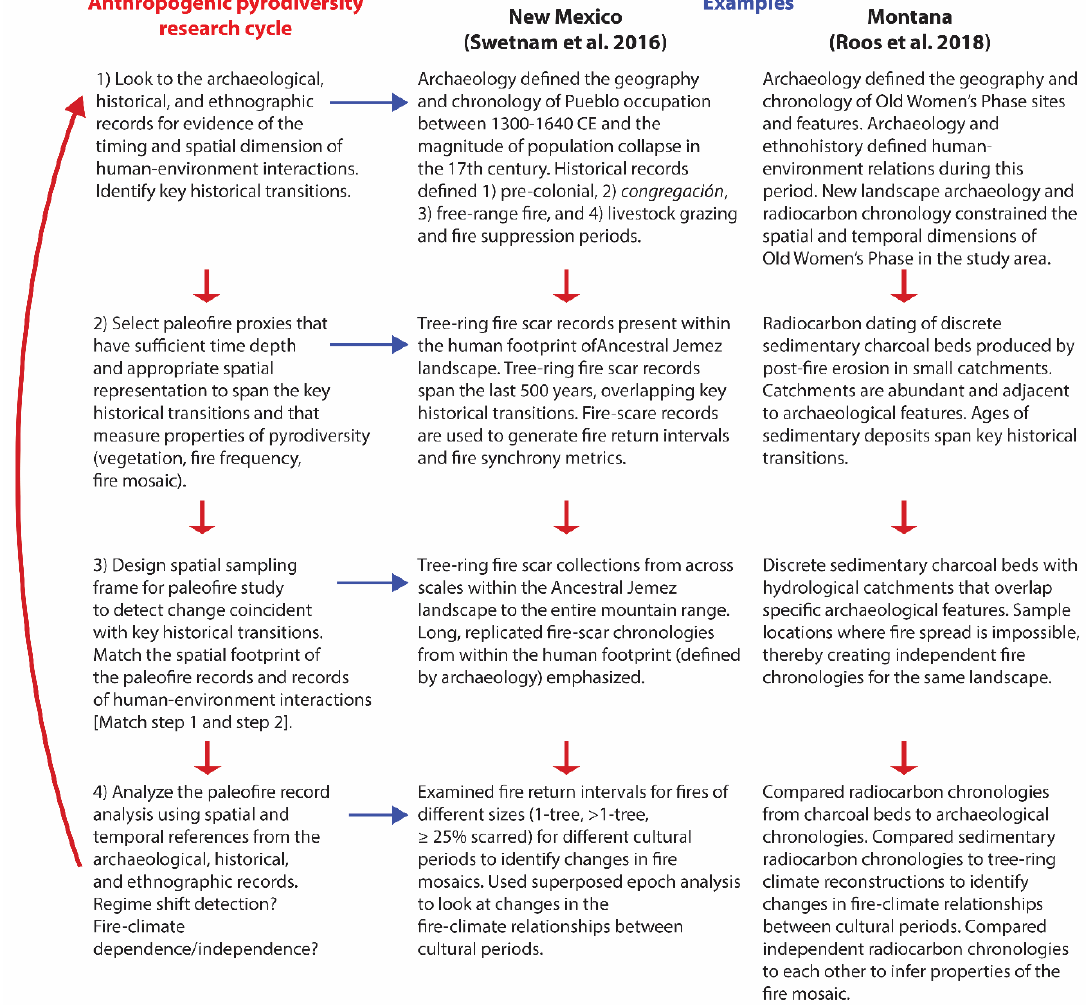
Figure 6. An idealized research process for integrating human information (archaeological, historical, ethnographic) and relevant paleofire information to identify anthropogenic pyrodiversity.